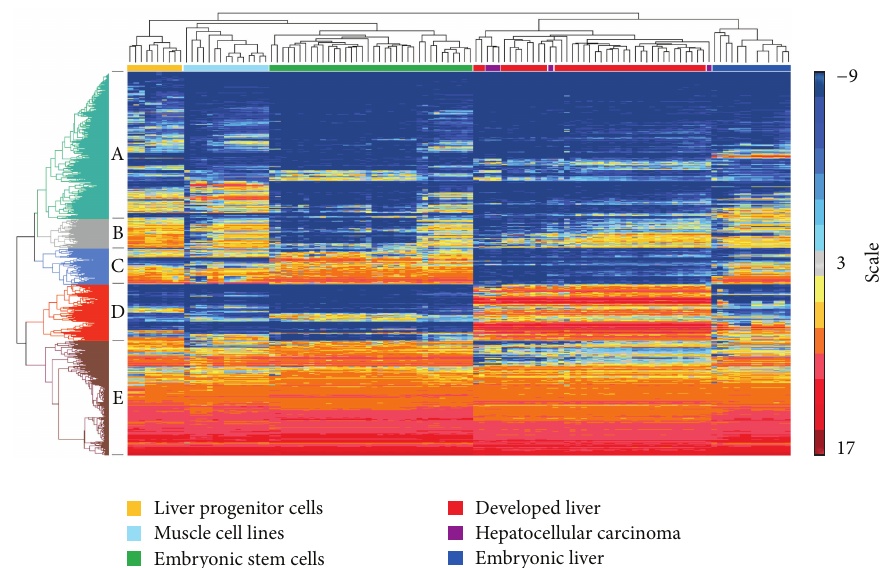
Figure 2: Hierarchical clustering identifies 5 clusters (A, B, C, D, and E) of distinct gene expression data for liver progenitor cells. ANOVA was performed to compare liver progenitor cells to all other cell/tissue type groups. The 8,623 probe sets that displayed expression levels significantly different to LPCs ( 𝑝 < 0.01 ) were subsequently clustered according to the parameters of Euclidean distance and complete